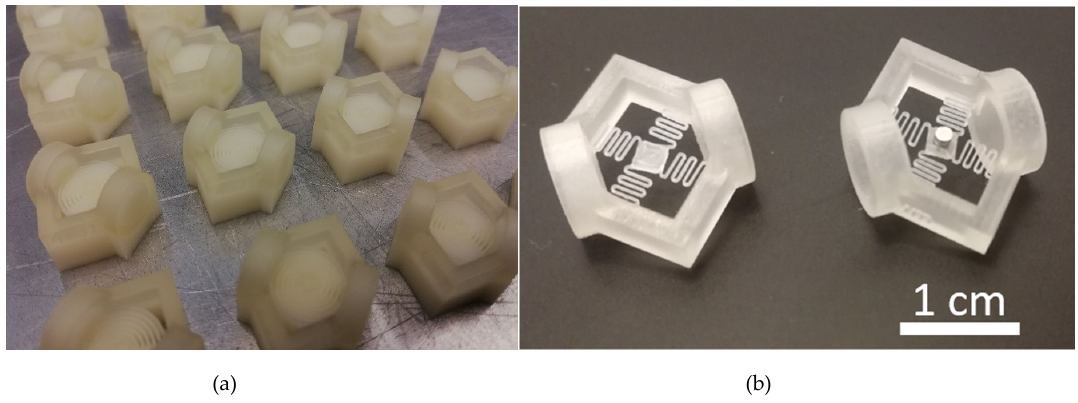
Figure 3. Vibrational 3D-printed MEMS-type energy harvesters: ( a ) after printing on the printing platform before support material removal, ( b ) an example of one of the printed structures without and with an assembled miniature magnet.